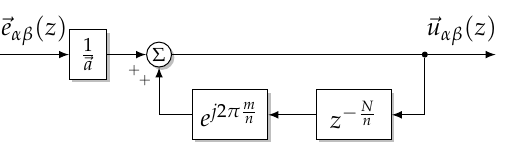
Figure 4. Block diagram of iGDSC based SV-RC with positive feedback